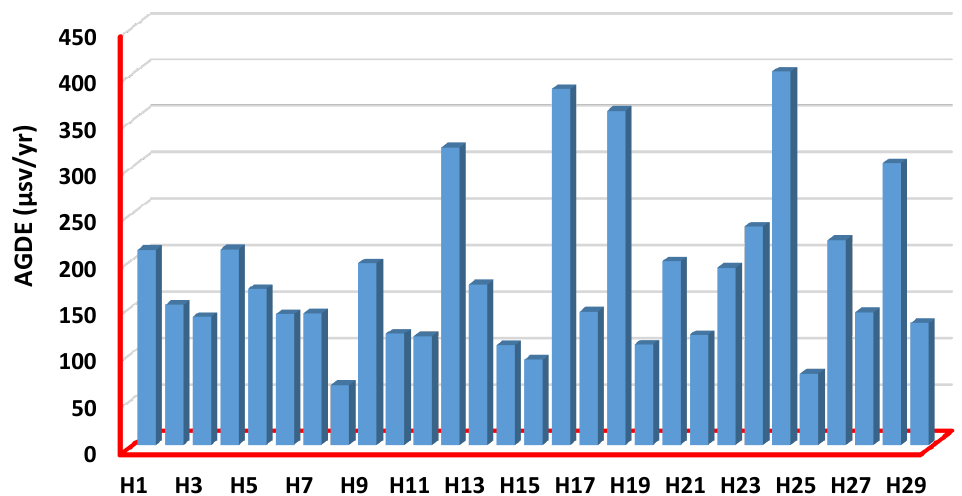
Figure 9. The annual gonadal equivalent dose (AGDA) in the various species of the medicinal plant samples. Table 6. Outdoor and indoor absorbed dose rate, internal hazard index ( H in ), external hazard index ( H ex ), and radioactivity level index ( I γ ) for different medicinal plant